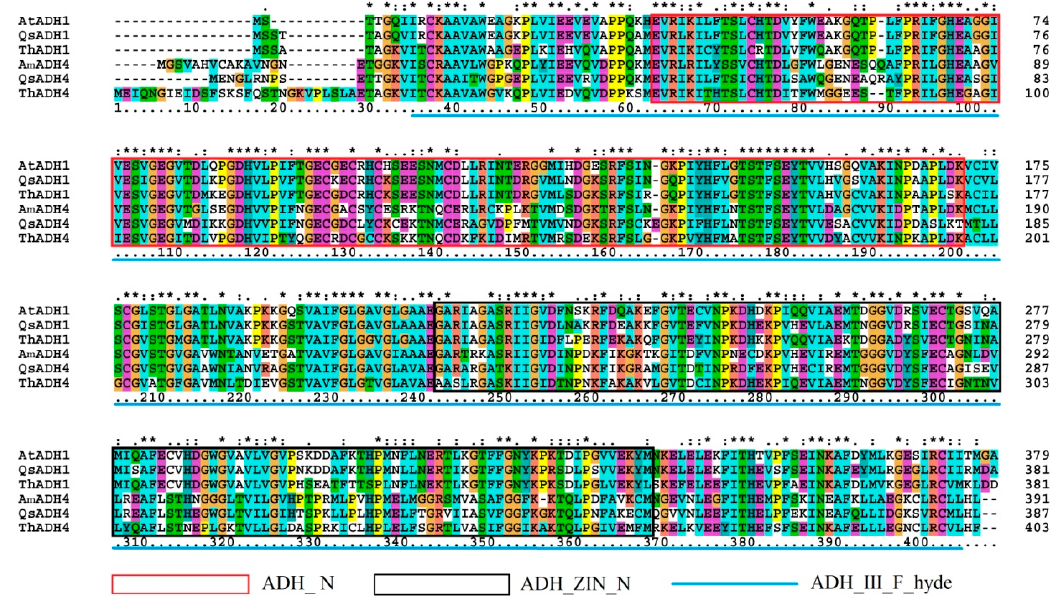
Figure 1. Alignment of the amino acid sequences of ThADH1, ThADH4 with Arabidopsis thaliana AtADH1, Quercus suber QsADH1, QsADH4 and Amborella trichopoda AmADH4. The highly conserved regions of the ADH proteins are shown by the red, black boxes and blue line, which represent the following conserved domains: ADH_ N domain, ADH_ZIN_N domain and ADH_III_F_hyde